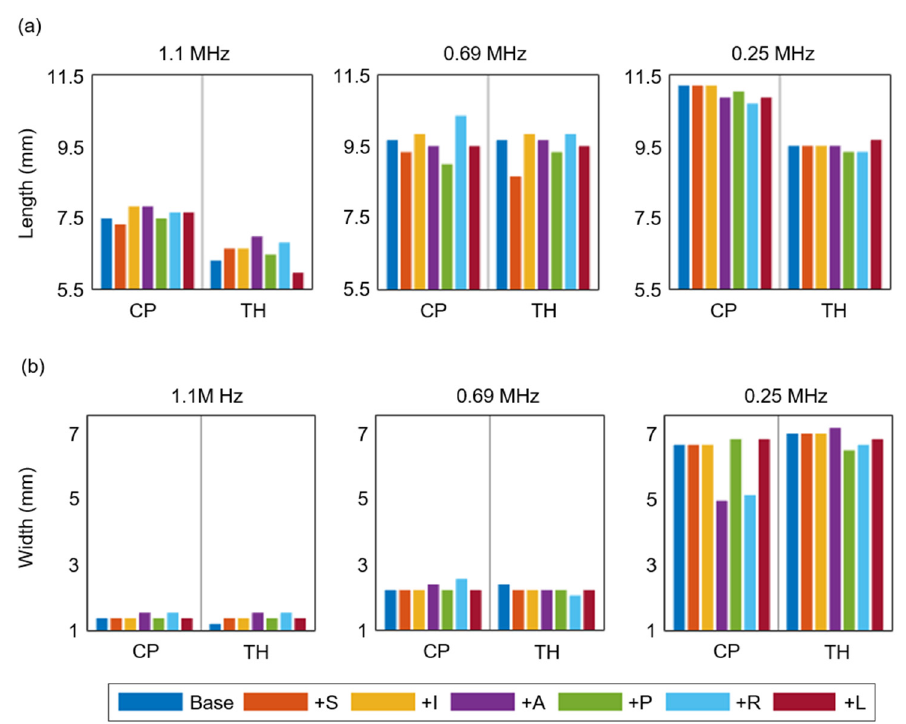
Figure 7. The comparisons of length ( a ) and width ( b ) of FWHM profiles at 1.1, 0.69, and 0.25 MHz under the transducer displacements in all six directions relative to its base location.